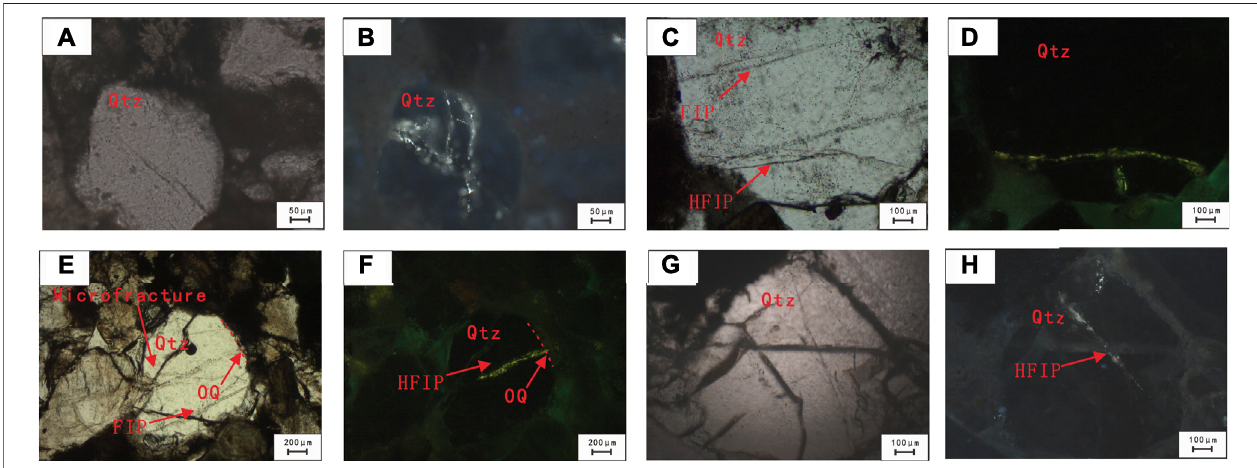
FIGURE6| Thinsectionimagesofsamplesinplane-polarizedlight (A,C,E,G) andultra-violetlightimagesofthesameareas (B,D,F,H) . (B) X-shapedconjugated HFIP in quartz grains. (E) “ Hertzian ” contact points formed preferred orientation of microfractures and FIPs through the grain and quartz overgrowth which is indicated using a red dotted line. (G) Different generation microfractures and HFIP in crosscutting.